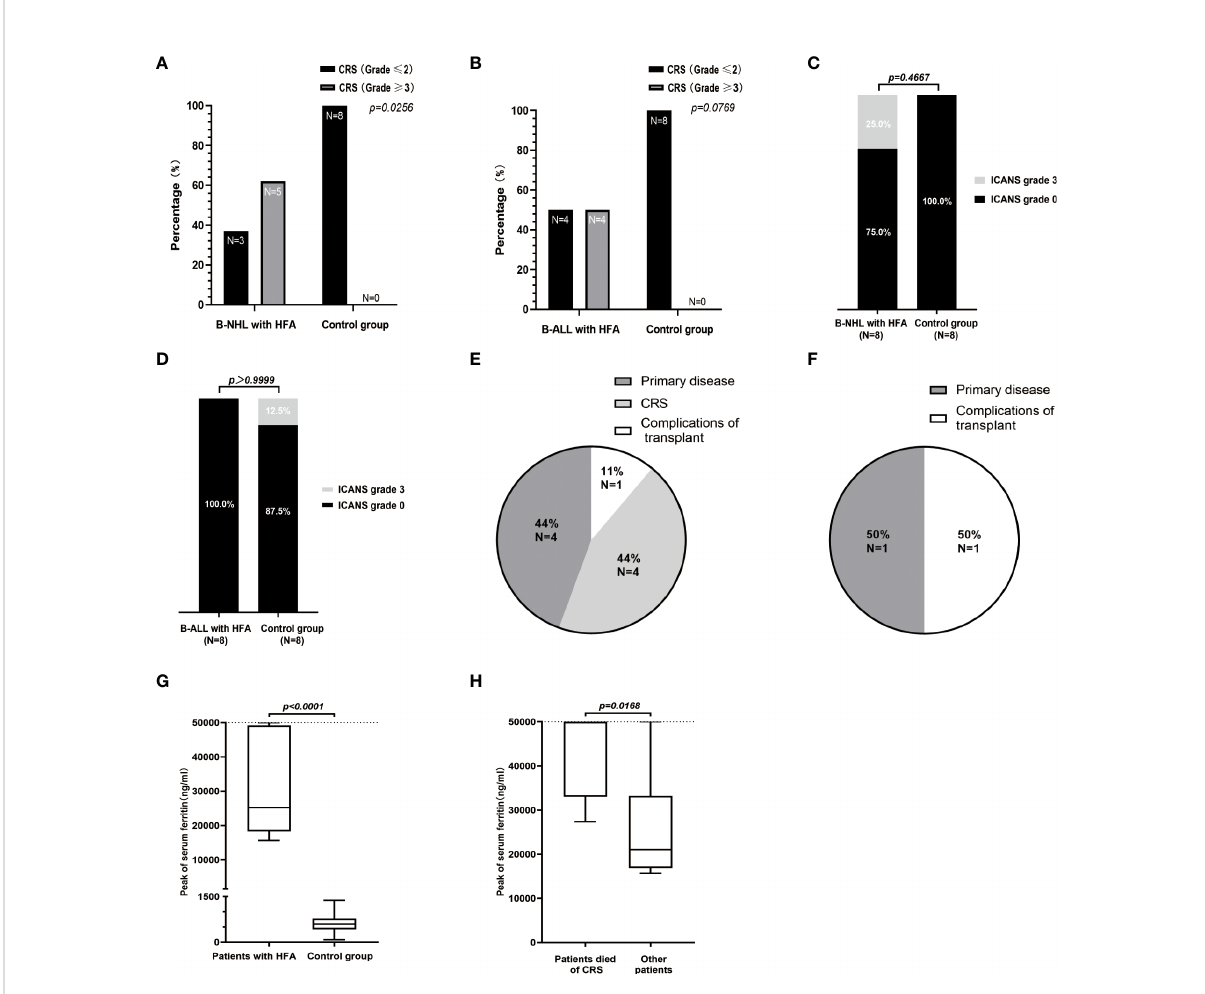
FIGURE 2 Safety assessments of the 32 patients in B-NHL and B-ALL cohorts. The percentage of patients with high-grade ( ≥ 3) and low-grade ( ≤ 2) CRS in the B-NHL (A) and B-ALL (B) cohorts on the basis of hyperferritinaemia status. (C, D) ICANS developed in 3 patients (including 2 B-NHL patients in HFA group and 1 B-ALL patient in control group) and all were of grade 3. Causes of death for 9 cases of HFA group (E) and 2 cases of control group (F) . (G) The medians of the peak values of serum ferritin in HFA group (n=16) and control group (n=16) were 25257 (range, 15650-50000) ng/ml and 593.1 (range, 77.6-1384) ng/ml, respectively. (H) In the 16 HFA patients, the medians of the peak values of serum ferritin in patients who died of CRS (n=4) and other patients (n=12) were 50000 (range, 27370-50000) ng/ml and 21049.5 (range, 15650-50000) ng/ml, respectively. The horizontal lines in each box represent the median values, and the lower and upper boundaries of each box represent the 25th and the 75th percentiles, respectively, and the whiskers represent the minimum and maximum range. The detection upper limit of serum ferritin was 50000